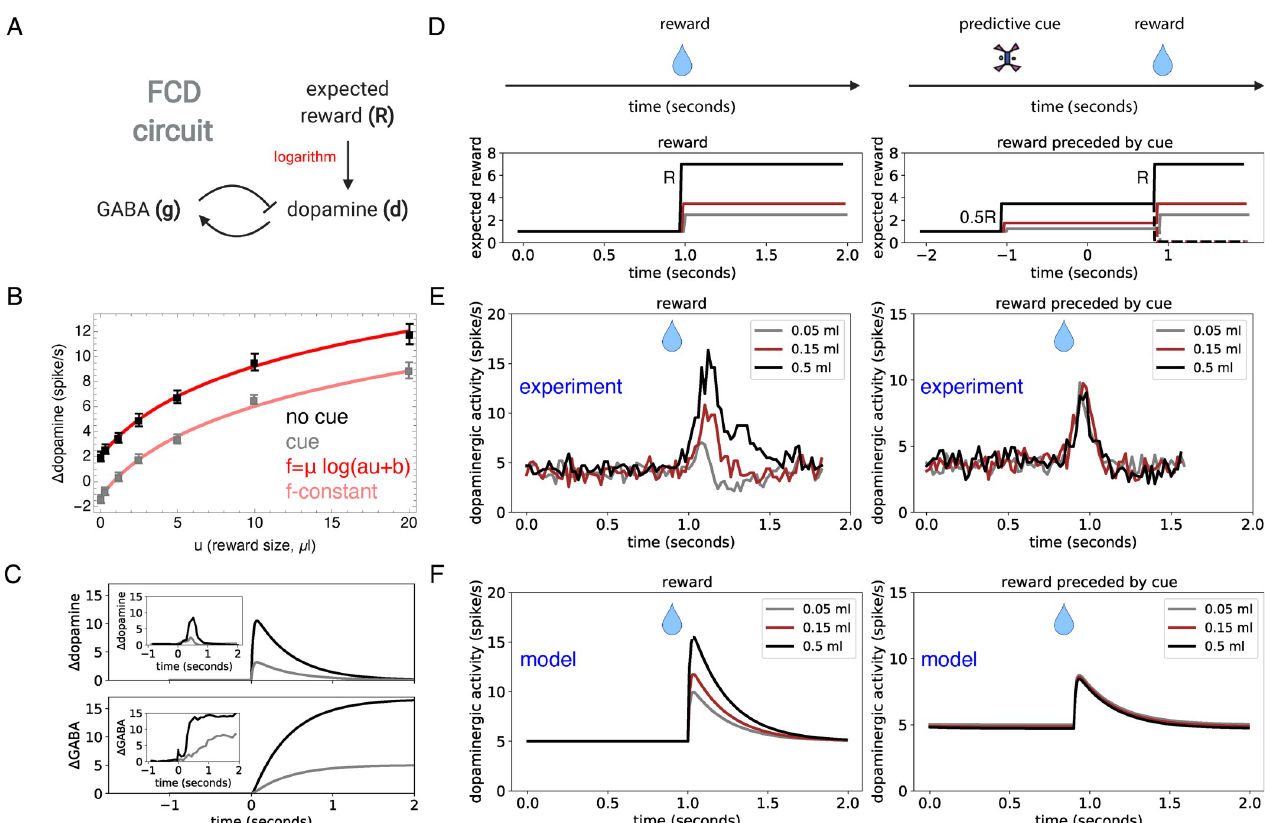
Fig 2. Logarithmic activation of dopamine dynamics explains scale invariant responses. (A) Minimal circuit for dopamine responses. Dopamine (d) is activated by the logarithm of expected reward (log R ) and is inhibited by negative feedback from GABAergic input ( g ). See Methods for equations and parameters. (B) The response of VTA dopaminergic neurons in mice (n = 5) to a water reward of variable volume (black squares, mean ± SEM, taken from Fig 1C in [38]) is well-described by the logarithmic relation Δ d = μ log( au + b ) (red line r 2 = 0.999, best-fit parameters a = 0.5 ± 0.1, b = 1.5 ± 0.05, μ = 4.9 ± 0.45, N = 7 reward magnitudes). When the reward is preceded by an odor cue (gray squares) the response is well-described by subtracting a constant from the uncued response (pink line, r 2 = 0.99, best-fit subtraction constant is − 3.2 ± 0.1). (C) Simulation of dopamine and GABA responses to a step increase in expected reward input which corresponds to the presentation of a reward-predicting cue. The step is given by R ( t ) = R 0 + λ θ ( t − t 0 ) where θ ( t − t 0 ) is a unit step function, R 0 = 1 and λ = 7 for the black line (large reward) and λ = 1.8 for the gray line (small reward). Insets . Average change in firing rates from dopaminergic (type I) and GABAergic (type II) VTA neurons, in response to reward-predicting cues for a small reward (gray) or a large reward (black). Data from Fig 2D of [49]. (DE) Population responses of dopaminergic neurons of two Macaque monkeys to variable size liquid reward, either without a preceding cue (left panels, n = 55 neurons), or with a preceding visual cue that predicts reward delivery with 50% probability (right panels, n = 57 neurons). (D) The expected-reward input following the reward-predicting cue is R = 0.5( b + λ u )(where λ is proportional to reward magnitude), which is doubled following reward delivery, R = b + λ u , where u is the reward magnitude (we use b = 2 and λ = 10 ml − 1 ). Dashed lines correspond to reward omission. (E) Experimentally measured average dopaminergic responses, using data from Fig 2A and Fig 4B of [26]. When the reward is delivered without a cue, dopaminergic responses increase with reward magnitude (left panel). When it is given after a cue that predicts reward delivery with 50% probability, dopaminergic responses to reward delivery are identical (right panel), as predicted by the FCD property. This is despite the 10-fold difference in reward magnitude. (F) Simulations of the dopamine model capture the experimentally observed dynamics. All simulation parameters are provided in Table 1.